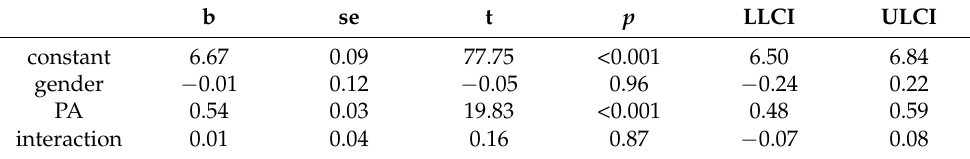
Figure 1. Simple moderation model in which gender is considered as moderator. Table 3. Regression analysis of SWB on PA, considering the moderating effect of gender.